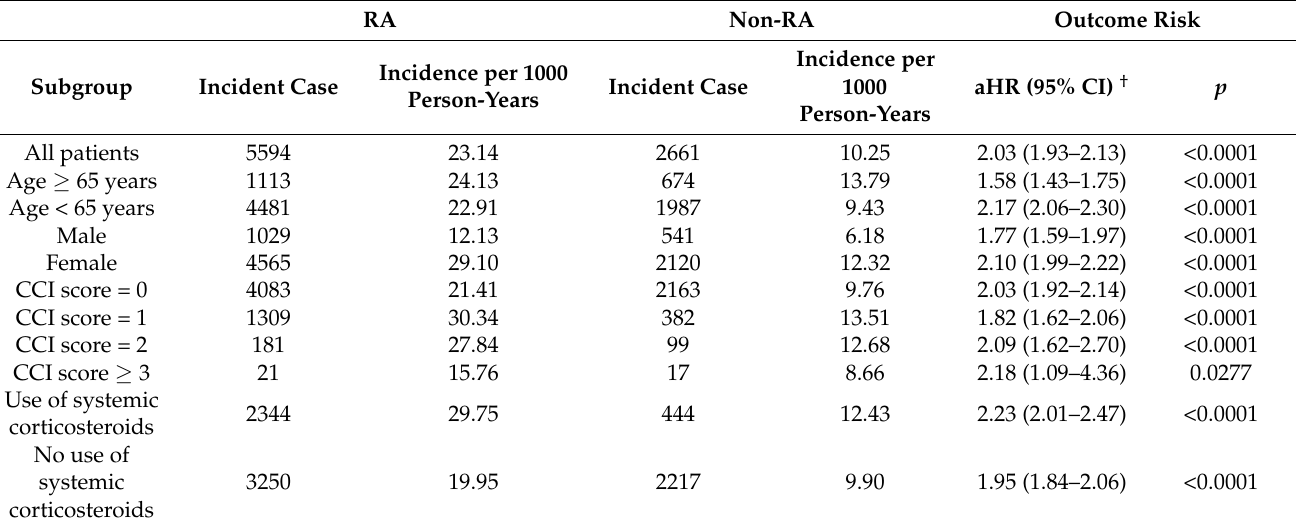
Table 4. Subgroup analysis of dry eye disease for patients with and without rheumatoid arthritis.